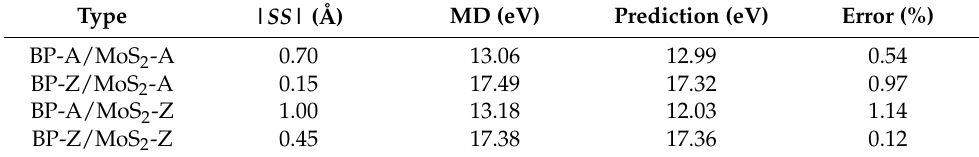
Table 3. The bending stiffnesses of BP/MoS 2 with four stacking